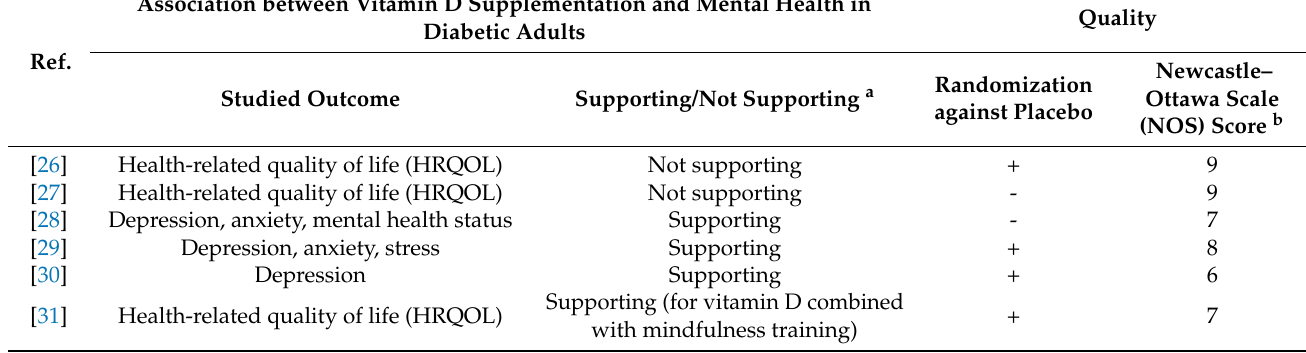
Table 6. The summary of findings presenting association between vitamin D supplementation and mental health in diabetic adults, accompanied by the Newcastle–Ottawa Scale (NOS) score for the studies included in the systematic review.